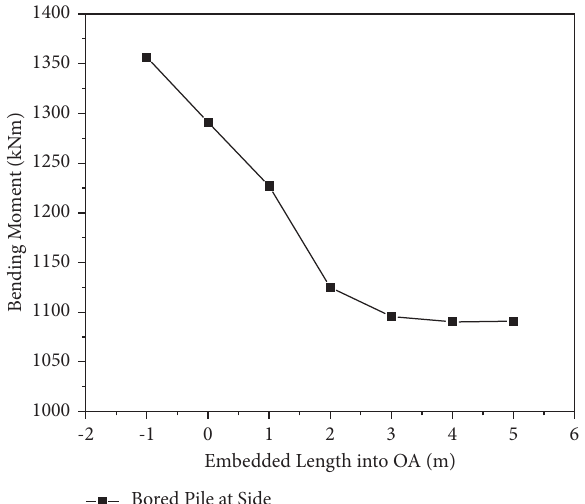
Figure 10: The effect of retaining wall embedded length into OA on bending moment of bore pile at side.